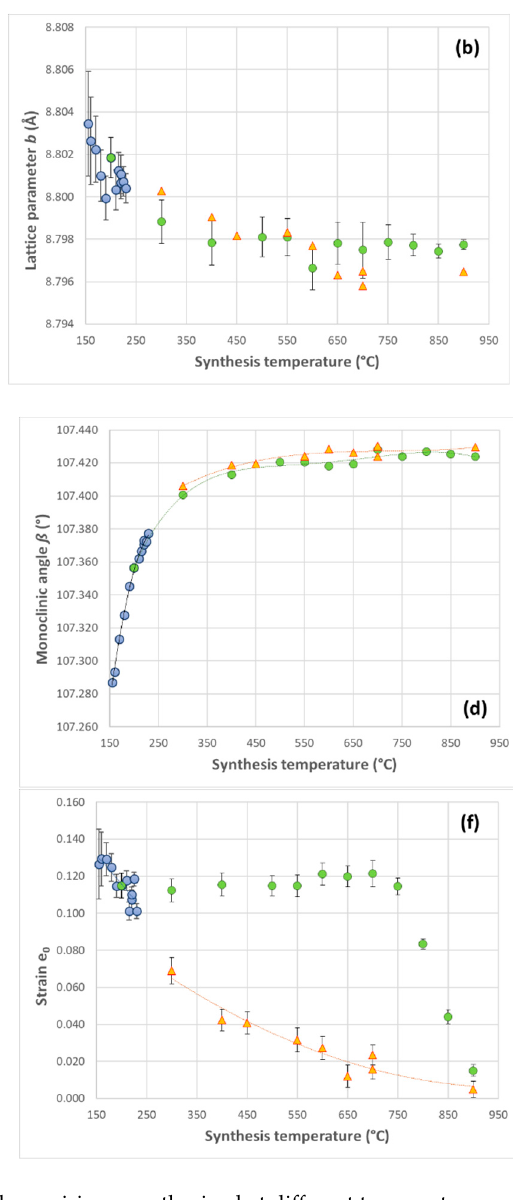
Figure 5. Variation of unit cell parameters ( a – e ) for the aegirines, synthesized at different temperatures between 155 °C and 230 °C (blue circles), for the aegirine obtained at 200 °C and sintered at different temperatures (green circles) and aegirines obtained from hydrothermal synthesis by [4] and reevaluated in this study (orange triangles), ( f ) gives the variation of dimensionless strain. Polynomial functions of 2nd to 3rd order were fitted to the data and serves as a guide to the eye only.